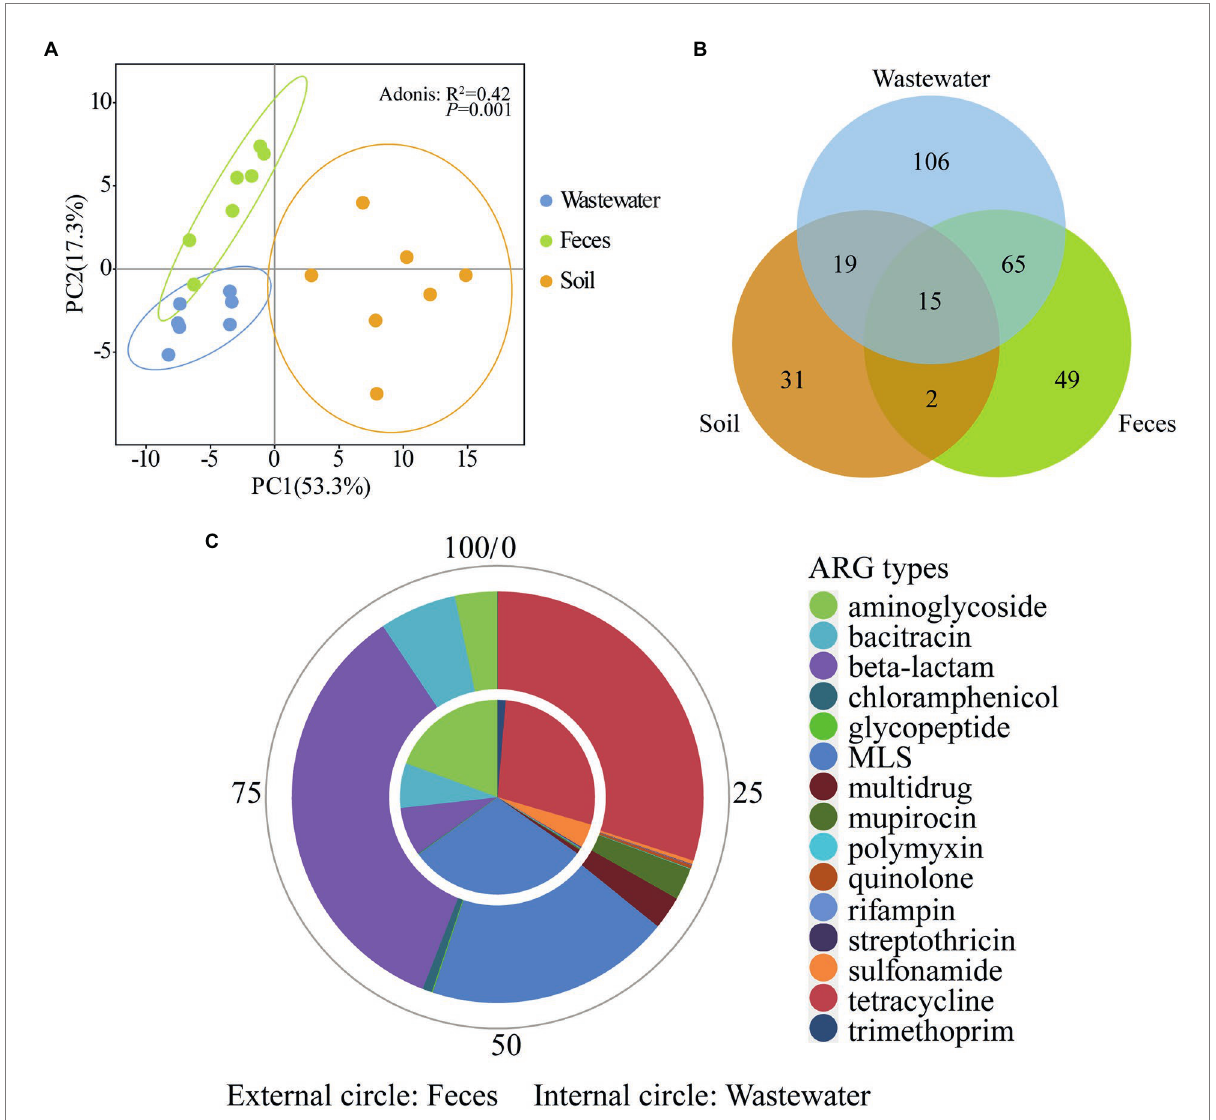
FIGURE 4 Comparison of ARGs across wastewater, feces, and soil in dairy farms. (A) PCA plots (coverage, × /Gb, log2 transferred) of 21 environmental samples. (B) Shared ARGs across three sample types. (C) The relative abundance of shared ARGs between wastewater and